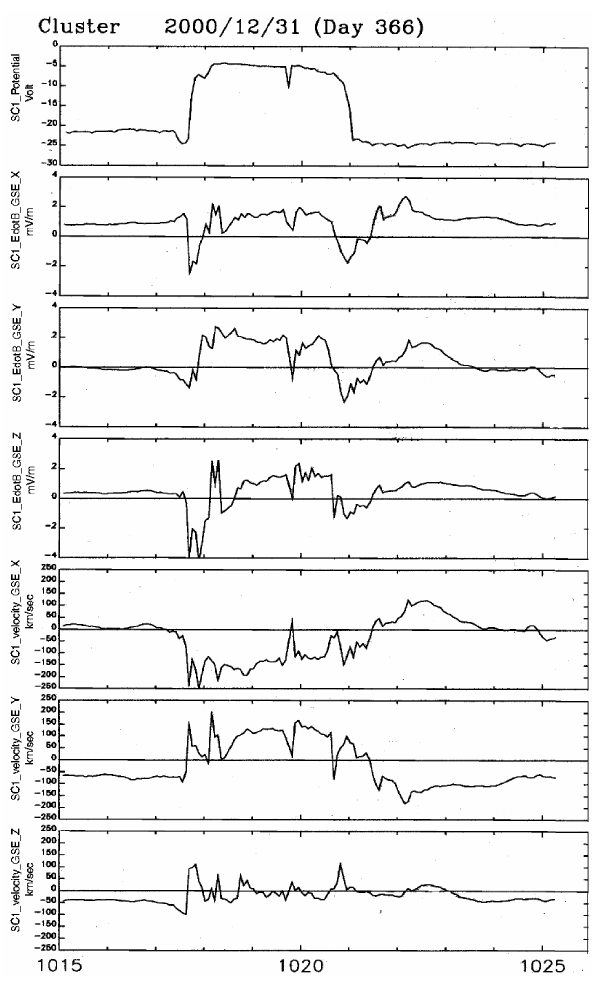
Fig. 8. An example of a magnetopause crossing (between 10:15– 10:25 UT) where the spacecraft entered the magnetosheath and re- turned three minutes later. The figure demonstrates the detailed be- haviour of the spacecraft potential (plasma density), electric field and plasma flow near the